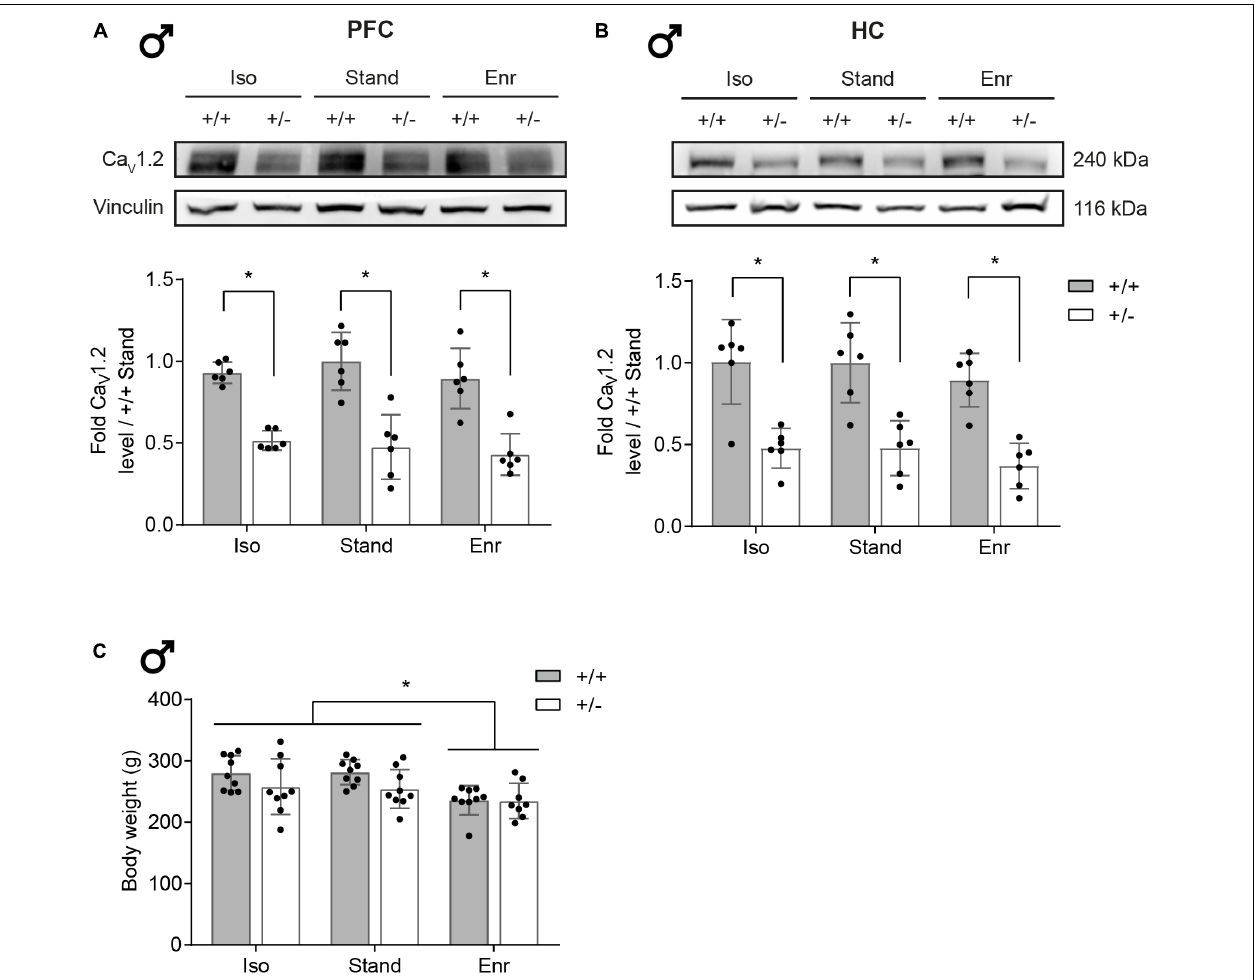
FIGURE 2 | Ca V 1.2 protein levels in rat brain and body weight. Ca V 1.2 protein expression levels in the right prefrontal cortex and hippocampus of 2-month-old male Cacna1c + / − rats and Cacna1c + / + littermate controls from the different environmental conditions were analyzed by Western blot. (A) One representative immunoblot per brain area is shown. (B) The bar graphs were obtained by densitometric quantification of the Western blot data. The values are normalized to the loading control vinculin and presented as fold of Cacna1c + / + -Stand (mean ± SD, n = 6). (C) Whole body weight was determined after the 4-week exposure to the experimental housing conditions at ∼ 2 months of age (mean ± SD, n = 8–9). Statistical significance is highlighted by an asterisk ( ∗ ). +/+, wildtype Cacna1c + / + ; + / − , heterozygous Cacna1c + / − ; Iso, isolation; Stand, standard housing; Enr,